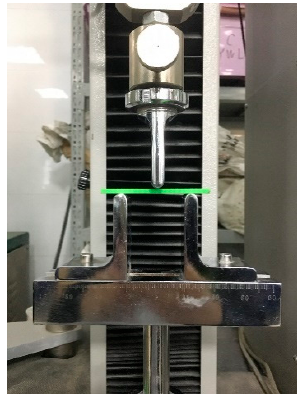
Figure 23. Three-point bending test.